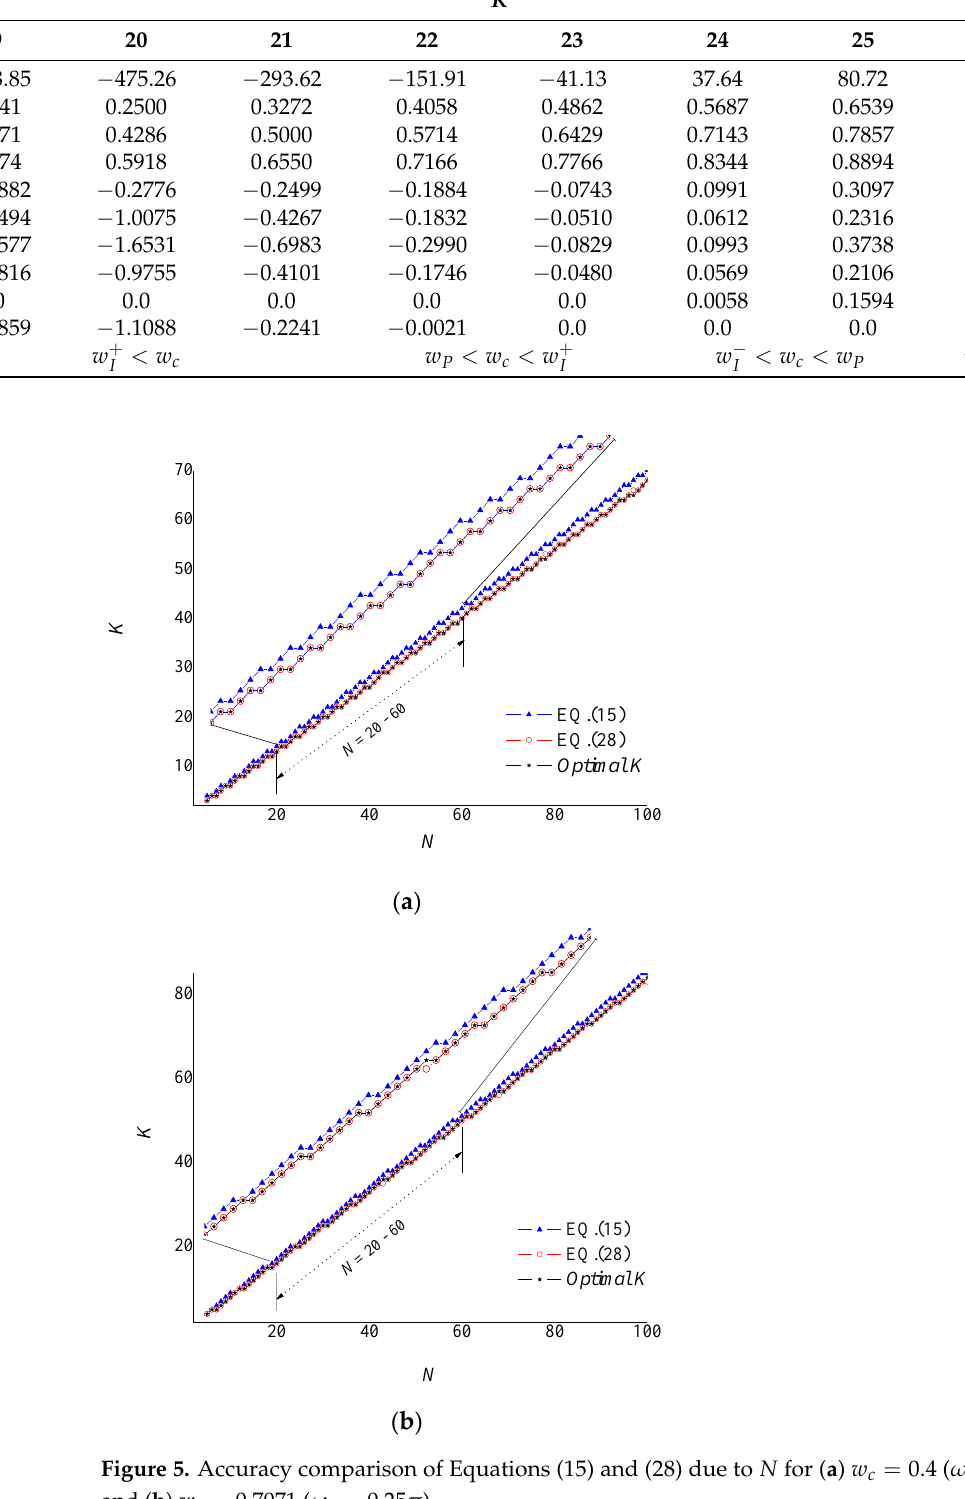
Figure 5. Accuracy comparison of Equations (15) and (28) due to 𝑁 for ( a ) 𝑤 𝑐 = 0.4 ( 𝜔 𝑐 = 0.369𝜋 ) and ( b ) 𝑤 𝑐 = 0.7071 ( 𝜔 𝑐 = 0.25𝜋 ).